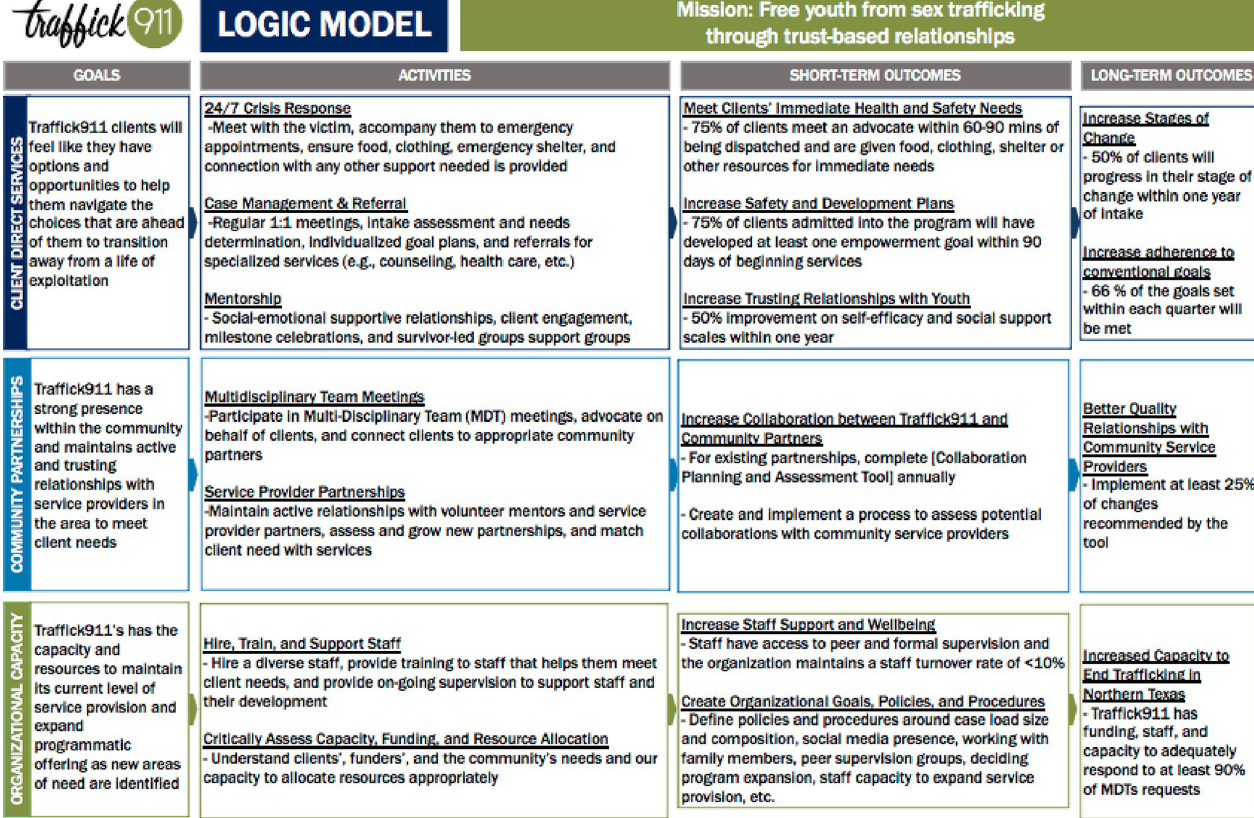
PLOS ONE | https://doi.org/10.1371/journal.pone.0270103 June 29,